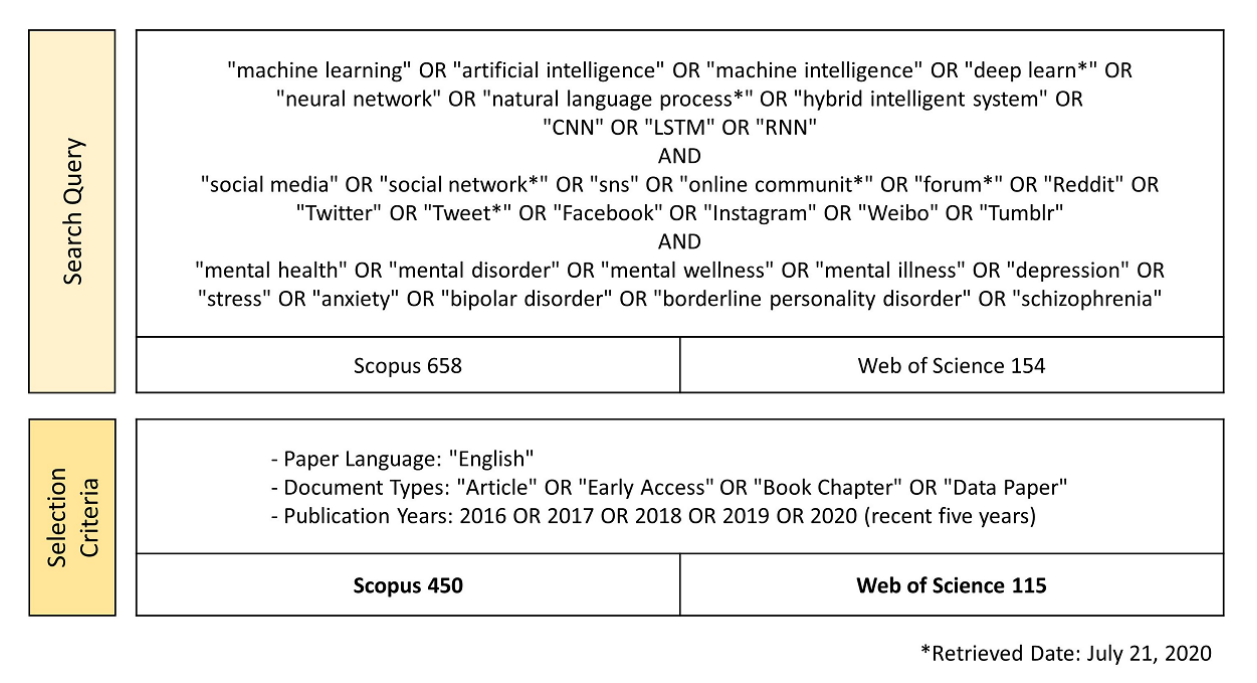
Figure 1. Representative data collection